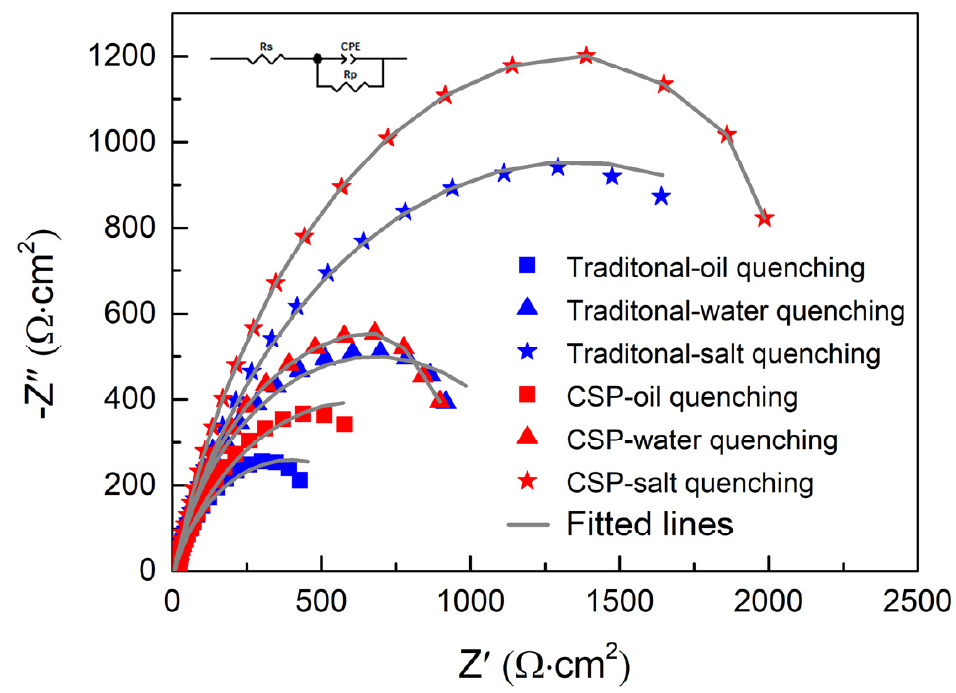
Figure 7. Electrochemical tests of Nyquist plots were tested for the samples produced by traditional and CSP processes quenched in the different quenching mediums.